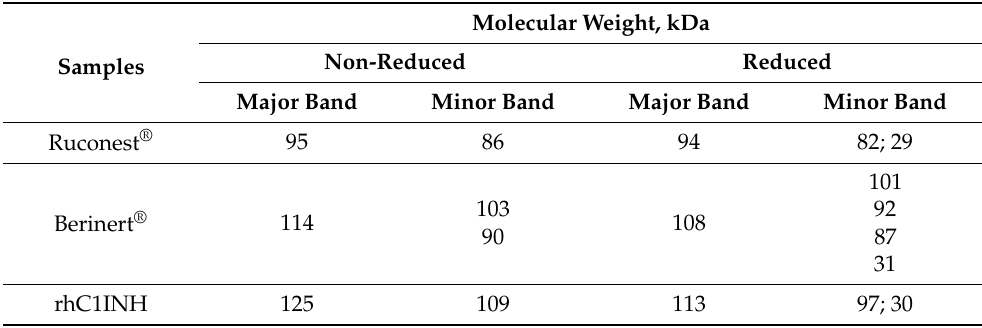
Table 2. The major protein bands identified by SDS-PAGE in the rhC1INH, Ruconest ® and Berinert ®